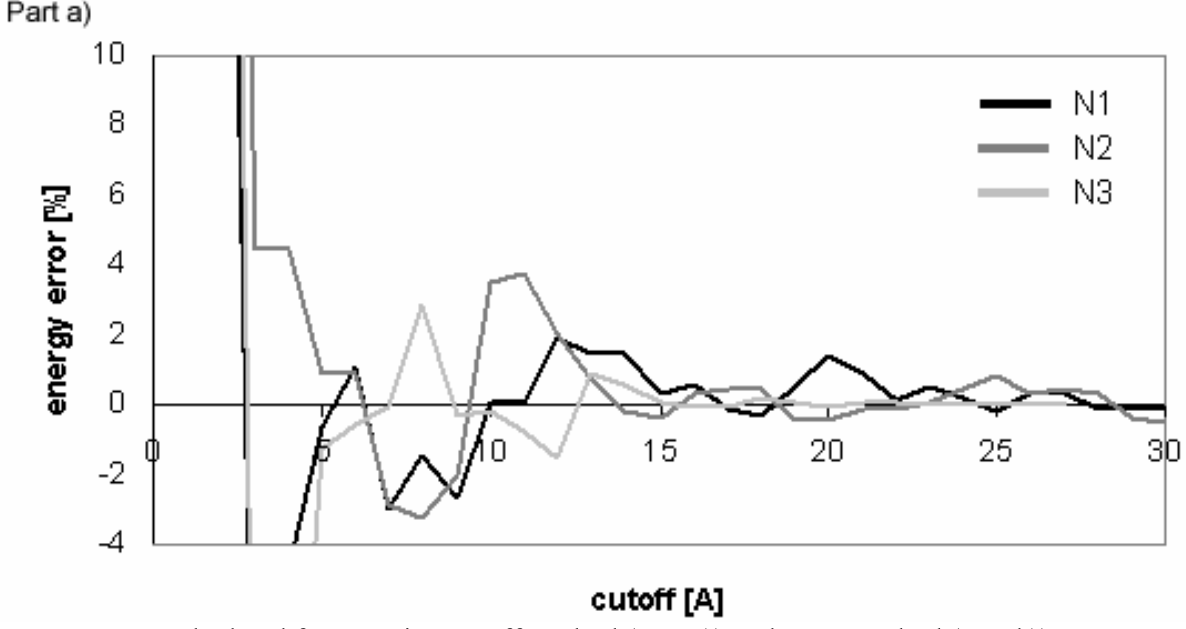
using cutoff method (Part a)) and PME method (Part b)). calculated for E el